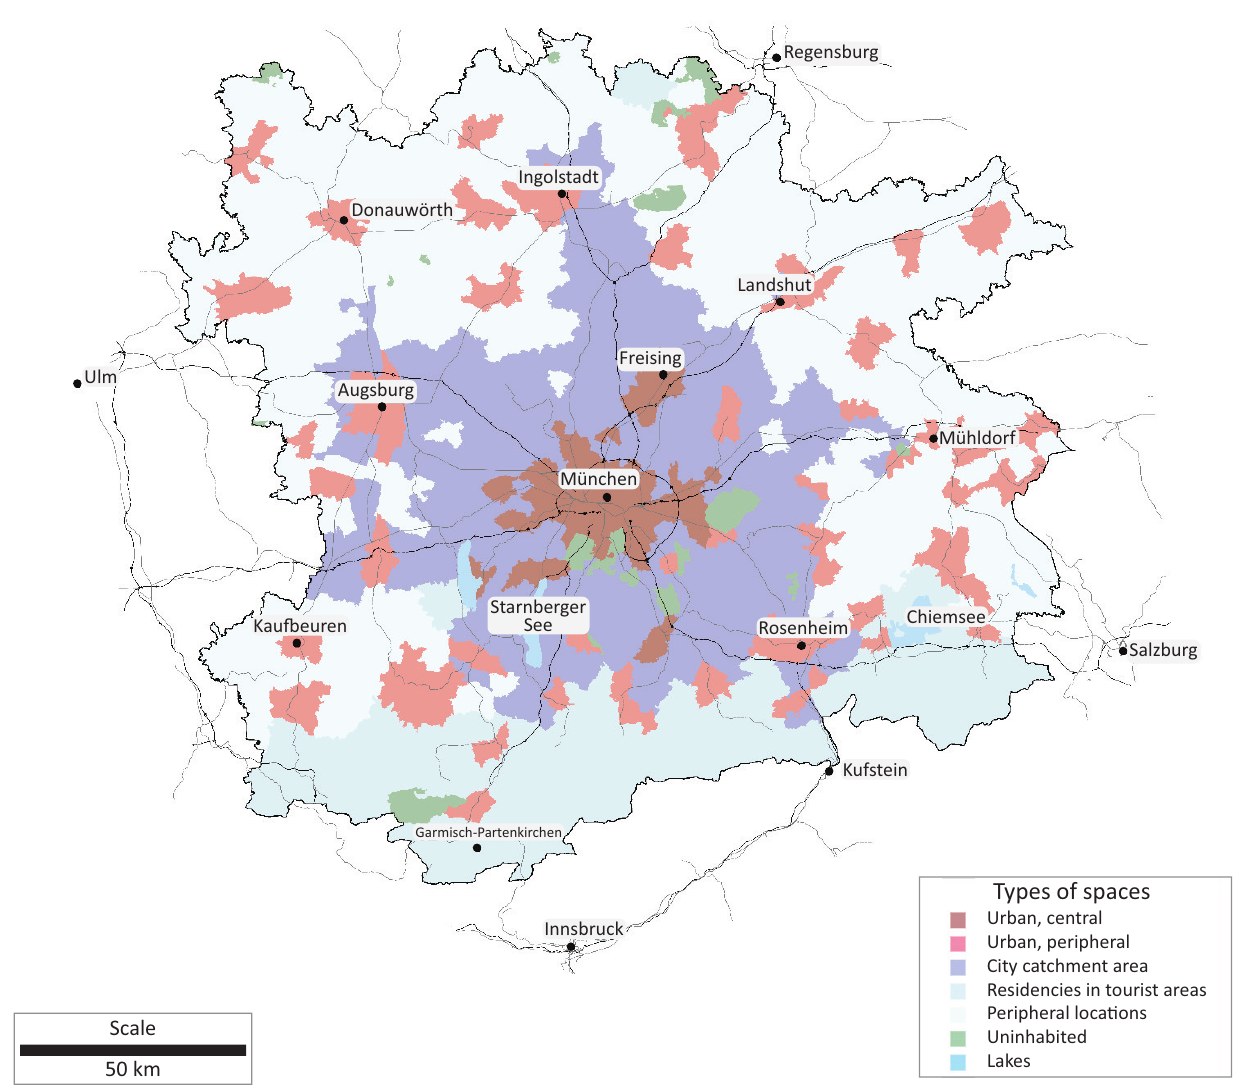
Figure 1. Types of spaces in the MMR. Source: Authors’ work based on Thierstein et al.